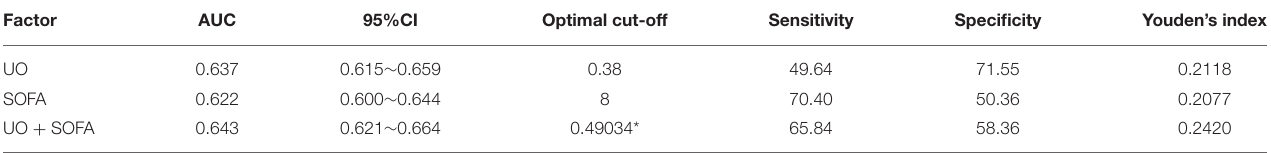
TABLE 5 | Comparison of ROC curves (after